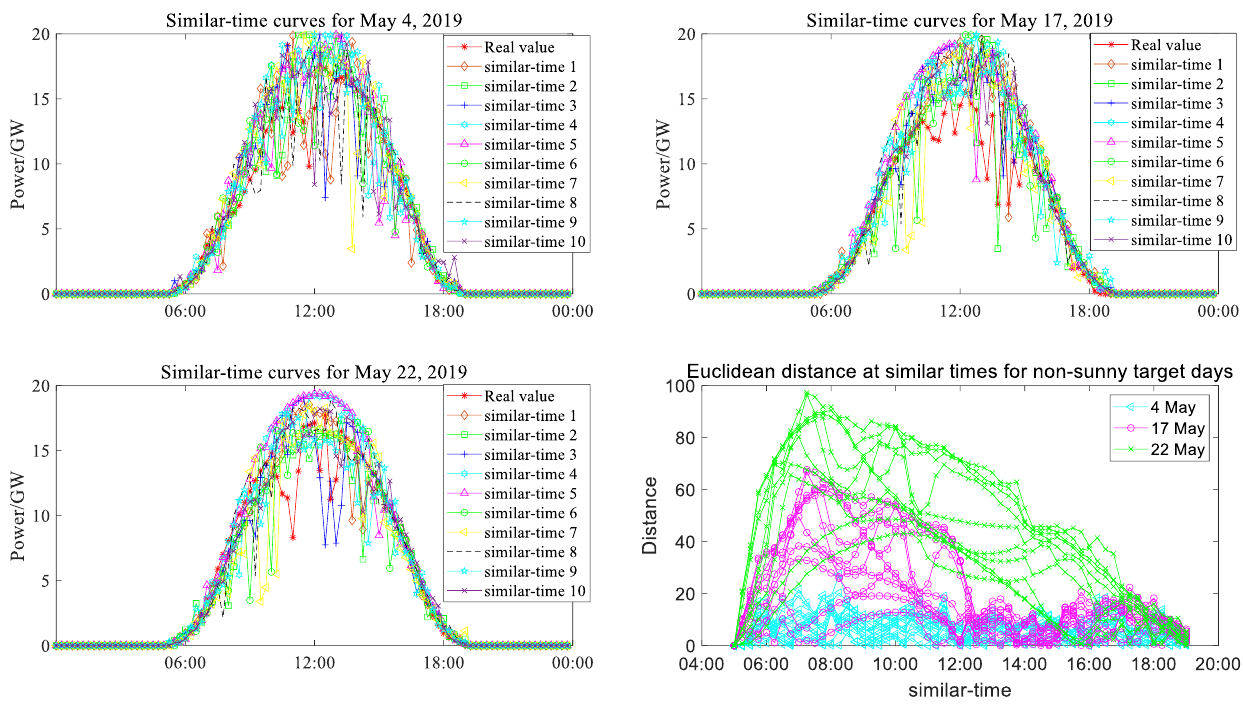
Figure 7. Similar-time curves and their Euclidean distances for sunny target days.